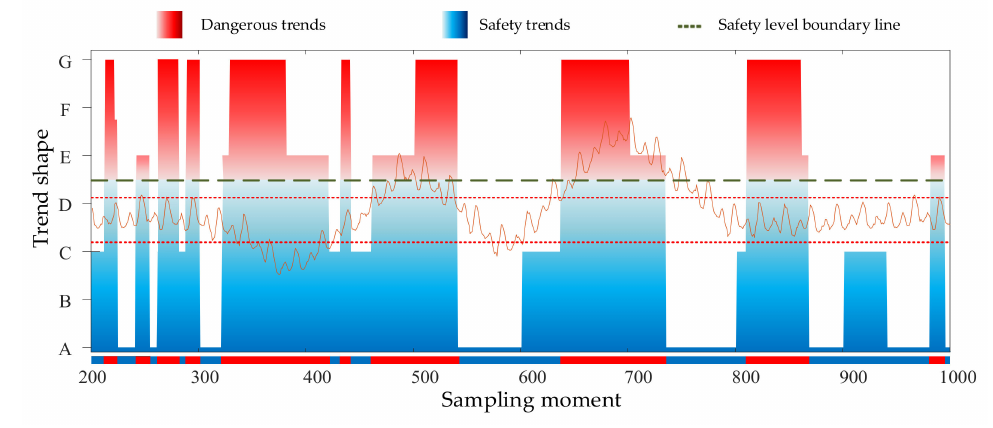
Figure 13. The curve trend distribution diagram of the d